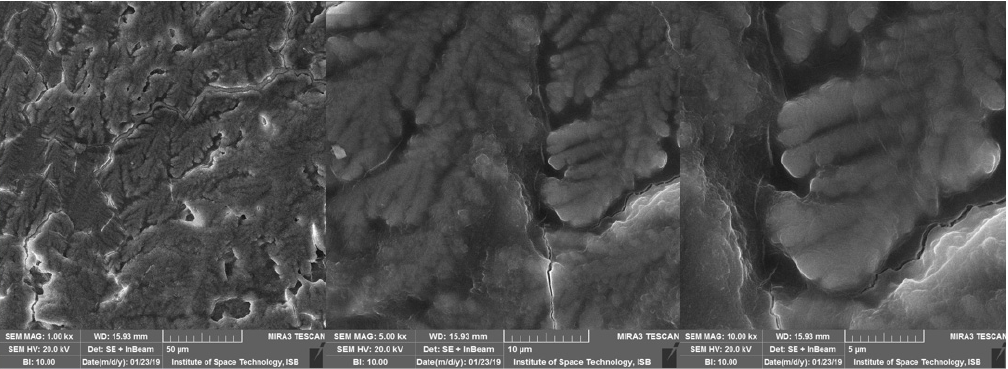
Figure 5. Scanning electron microscopy images of CUI-P1 EPS molecules at 1.00 k×, 5.00 k× and 10.0 k×.